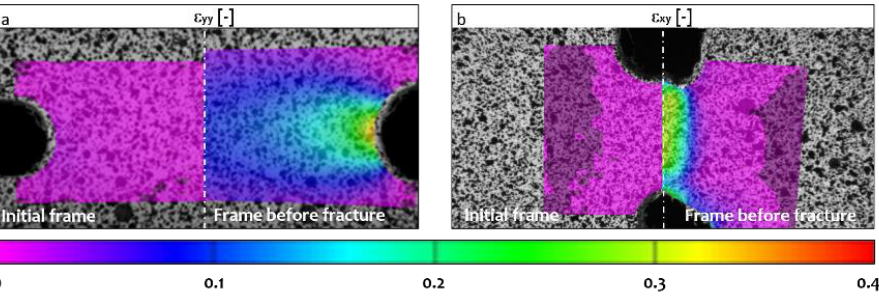
Fig. 5. Local strain measurement for a) a plane strain test and b) in-plane shear test, both performed at 10 -3 s